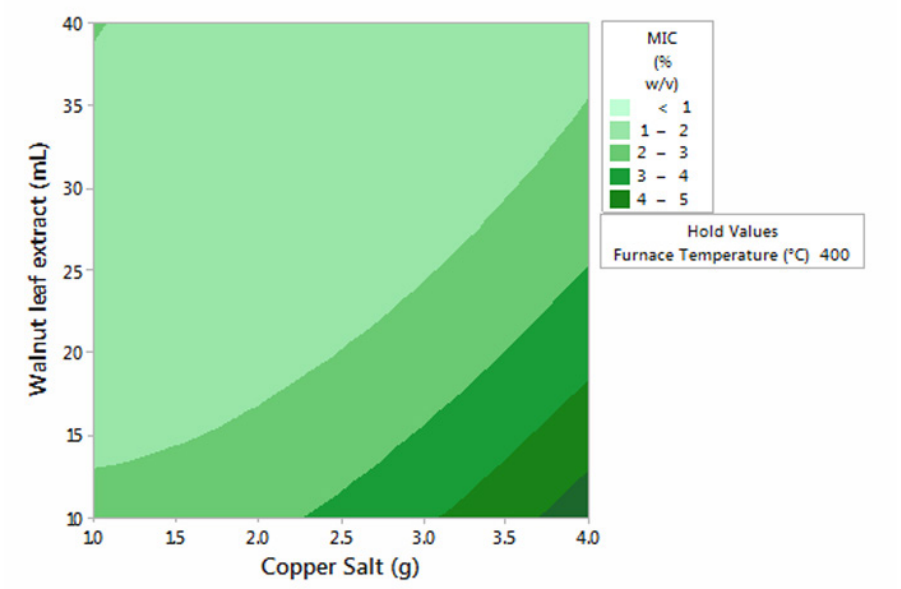
Figure 3: Contour plots for MIC of the formed CuO NPs as function of copper salt amount (g), amount of walnut leaf extract (mL) and furnace temperature